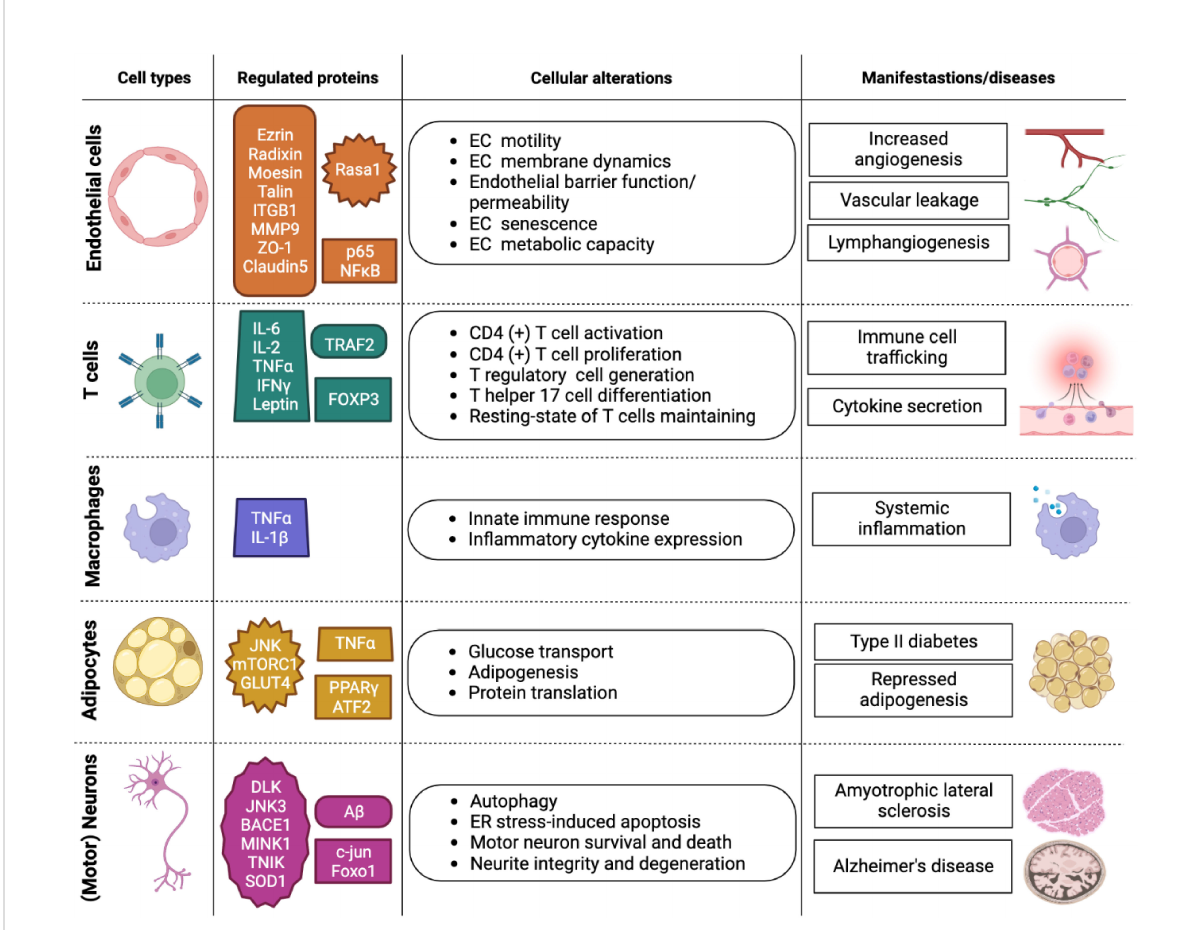
FIGURE 2 Overview of MAP4K4 functions in different cell types. Overview of MAP4K4 functions in endothelial cells, T cells, macrophages, adipocytes, and motor neurons. The column entitled regulated proteins highlights proteins that are either directly or indirectly regulated by MAP4K4 function. The column entitled cellular alterations states cellular activities affected by MAP4K4, and the column entitled manifestations/diseases indicates the corresponding physiological or pathophysiological contexts. EC, Endothelial cell; ER, Endoplasmic